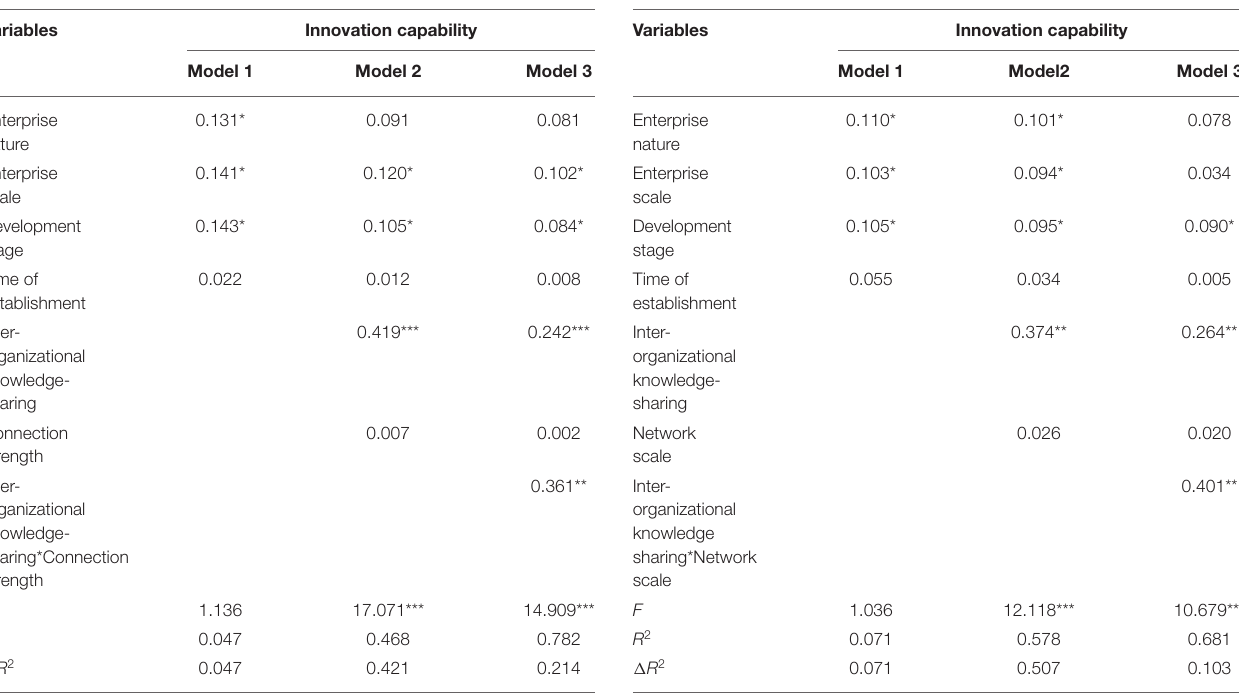
TABLE 9 | Moderator effect test of connection strength between inter-organizational knowledge-sharing and innovation capability.